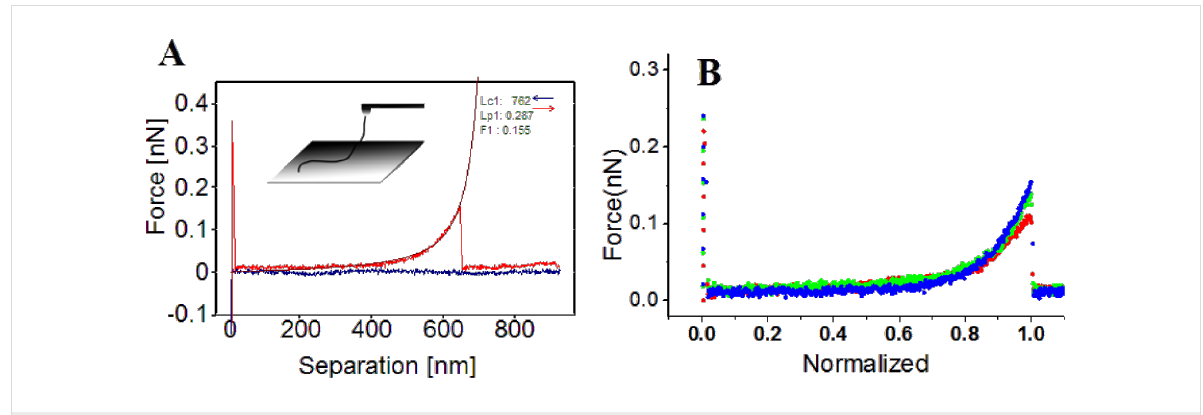
Figure 4: A) Typical “type 1” (t 1 ) force curve fitted with the WLC model. The inset is the model proposed to illustrate the single stretching events. B) The superposition of normalized single events ( n = 3).